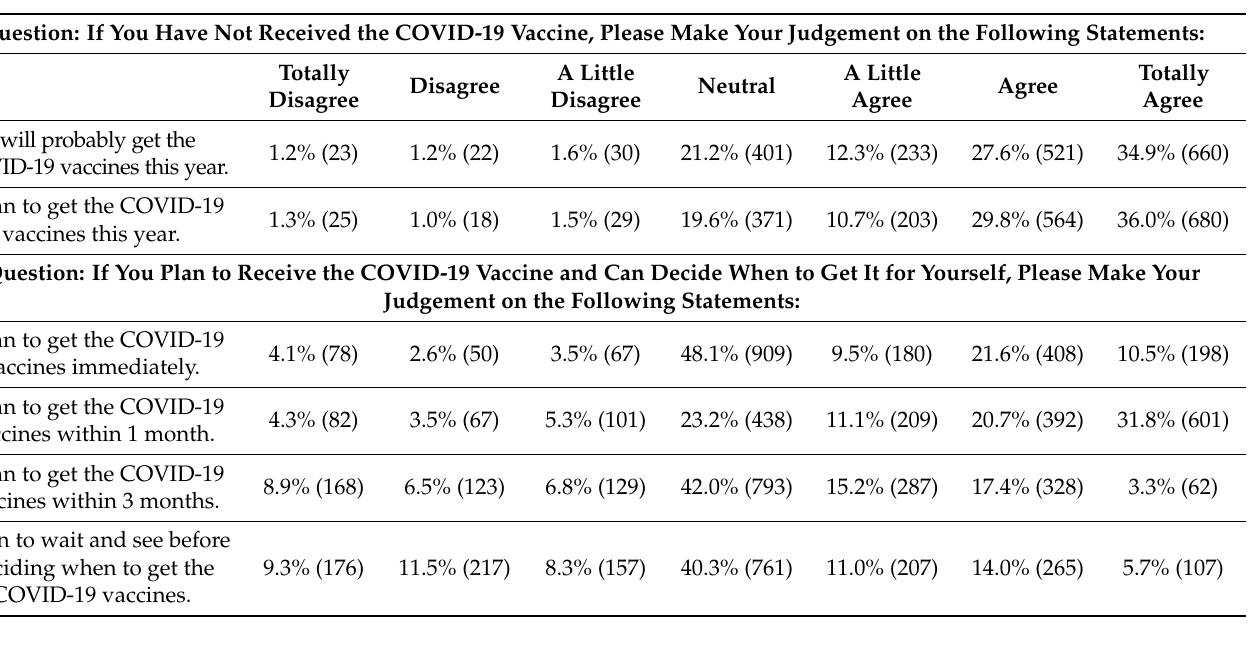
Table 2. The Chinese public’s intention to get the COVID-19 vaccine ( n =